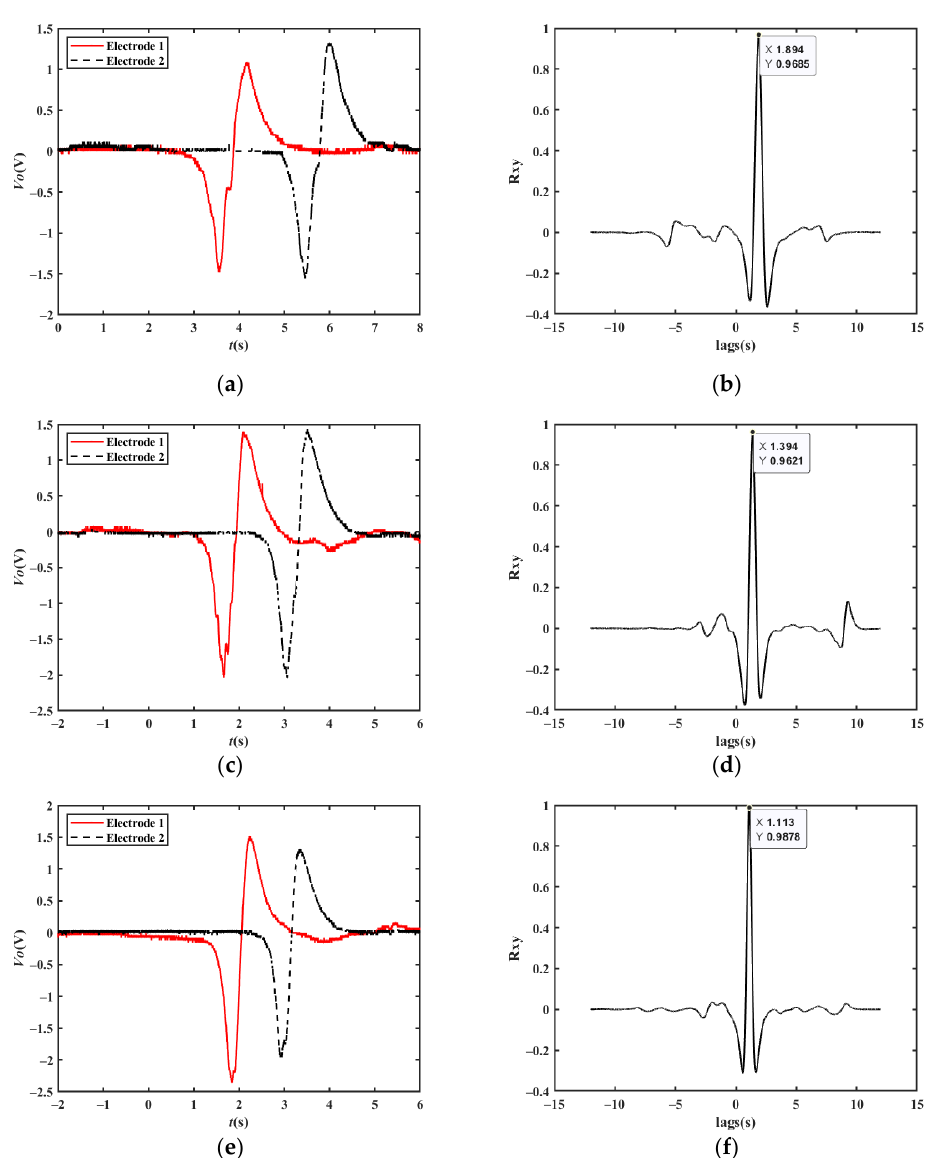
Figure 20. Experimental results at different vehicle velocities: ( a ) original waveforms at a velocity of 30 km/h; ( b ) cross-correlation results at a velocity of 30 km/h; ( c ) original waveforms at a velocity of 40 km/h; ( d ) cross-correlation results at a velocity of 40 km/h; ( e ) original waveforms at a velocity of 50 km/h; ( f ) cross-correlation results at a velocity of 50 km/h.